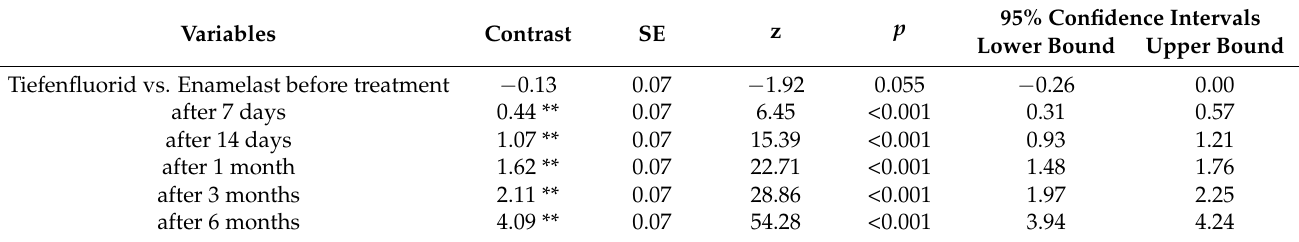
Figure 2. Predictive margins with 95% confidence intervals of DH pulp tester measurements at different timepoints. Table 4. Wald test for predictive margins of DH measurements stratified by time.